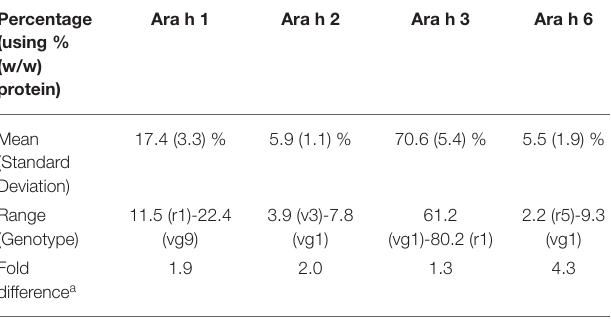
TABLE 1 | Overview of high-abundance peanut allergen abundancies. Percentage (using